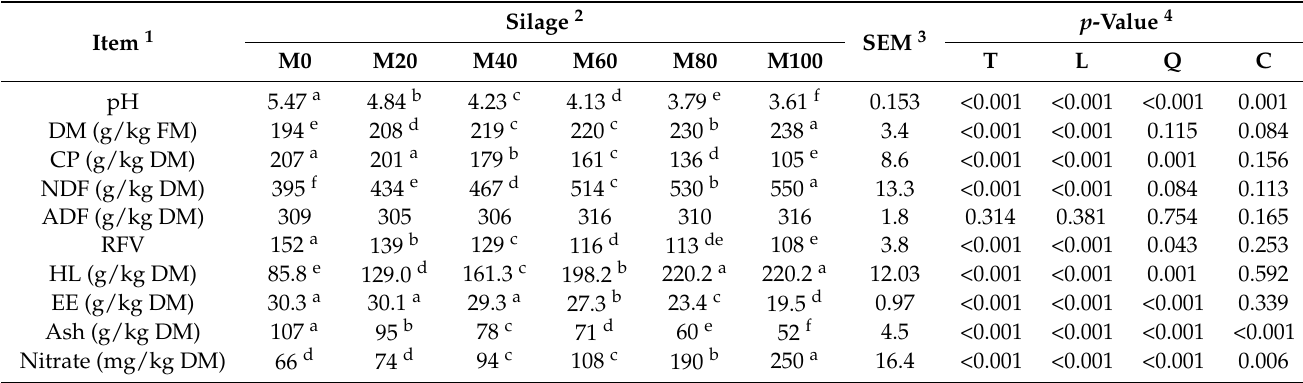
Table 1. The pH and chemical composition of silage prepared with lucerne, sweet maize stalk, and their mixtures ( n = 3).